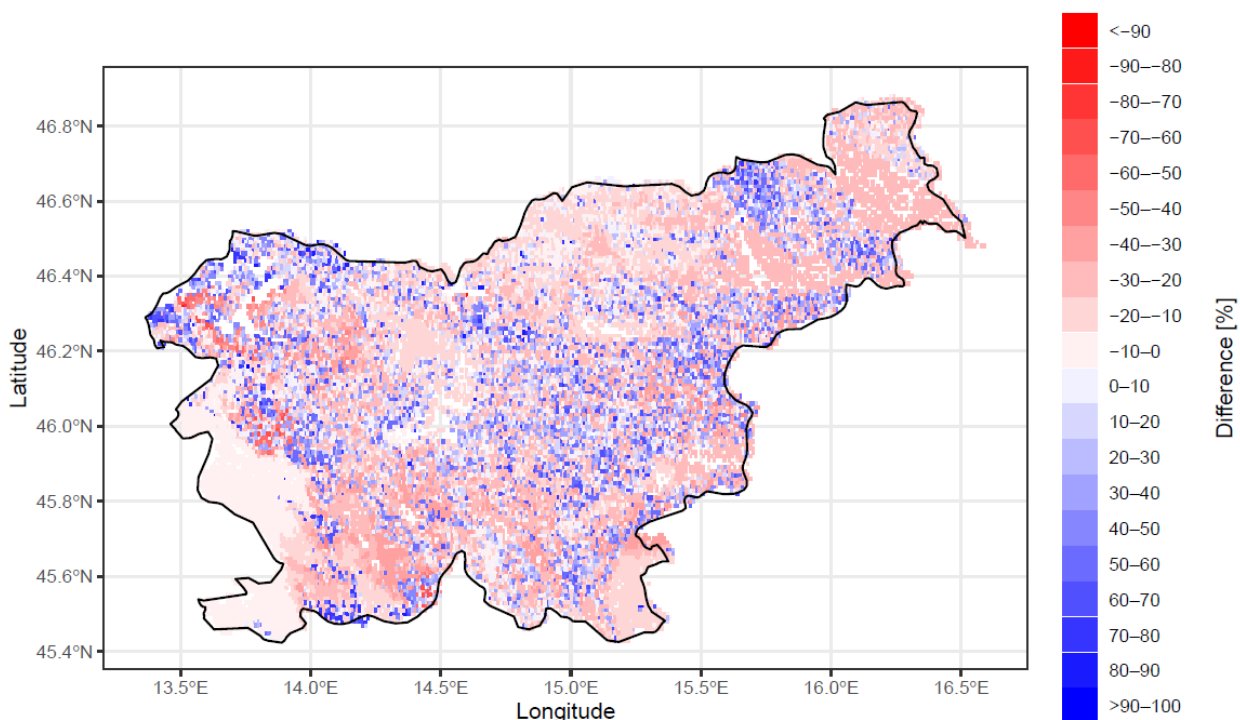
Figure 5. The difference between the observed and potential dominance of beech in Slovenia, as a percentage. Shades of red represent those stands with a lower than potential observed dominance of beech trees, while shades of blue represent the opposite.